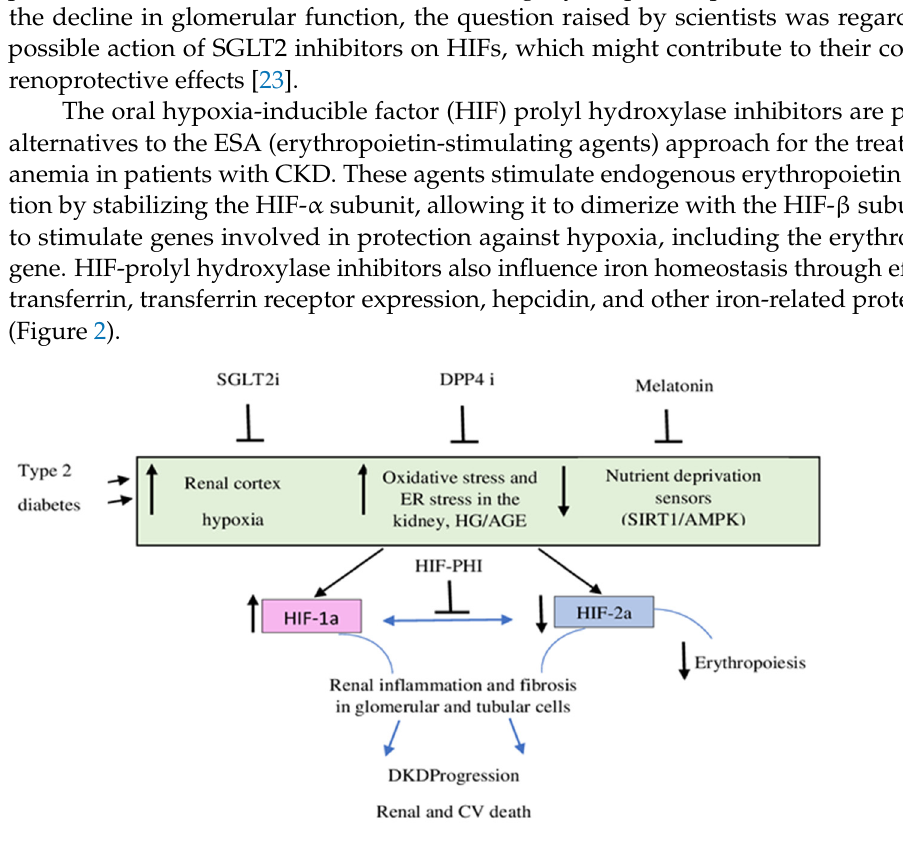
Figure 2. HIFs as triggers of diabetic nephropathy and potential effects of SGLT2i, DPP4i, melatonin, and HIF-PHI in reducing DKD progression (adapted from Packer M. [23]).